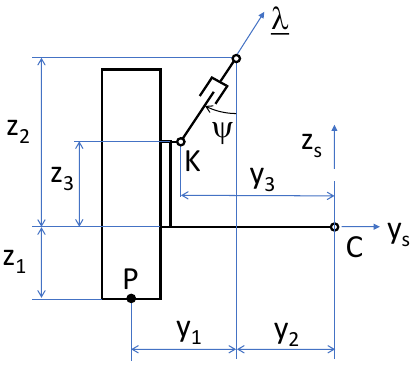
Figure 8. Swing axle